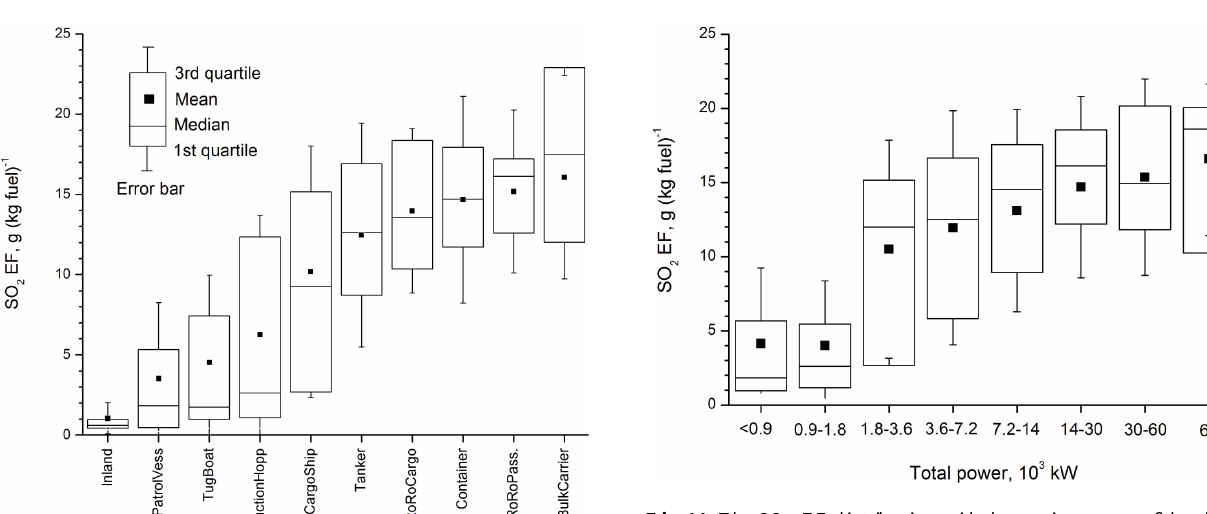
Fig. 11. The SO 2 EF distribution with the engine power of the ships. Figure 11. The SO 2 EF distribution with the engine power of the ships. The power 1017 The power range of the ships was divided into 8 intervals based on range of the ships was divided into 8 intervals based on logarithmic scale. Average 1018 logarithmic scale. Average SO 2 EFs of the bins are plotted along SO 2 EFs of the bins are plotted along the y-axes, while power bins are marked on the 1019 the y-axes, while power bins are marked on the x-axes. 1020